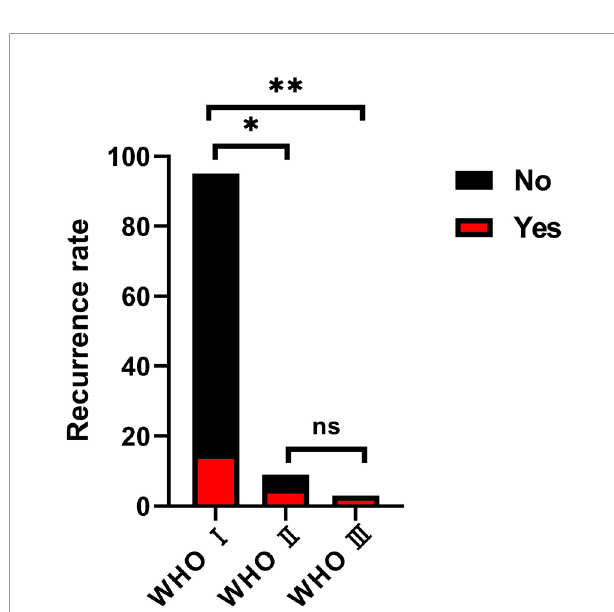
FIGURE 5 | The progressionor recurrence rateamong groups onthebasisof the pathological classi fi cation. the progressionor recurrence ratewas 15.8% (15/95 cases),55.6%(5/9patients) and 100%inthe WHOgrade I, II andIIIgroup, respectively. This wasstatisticallysigni fi cantwhenWHO gradeI comparedwith WHO gradeII (Chi-square test, *p <0.05) andIII(Chi-squaretest, **p< 0.05), but no signi fi cance betweengradeIIandgradeIII. (Chi-square test, ns, nosigni fi cance).